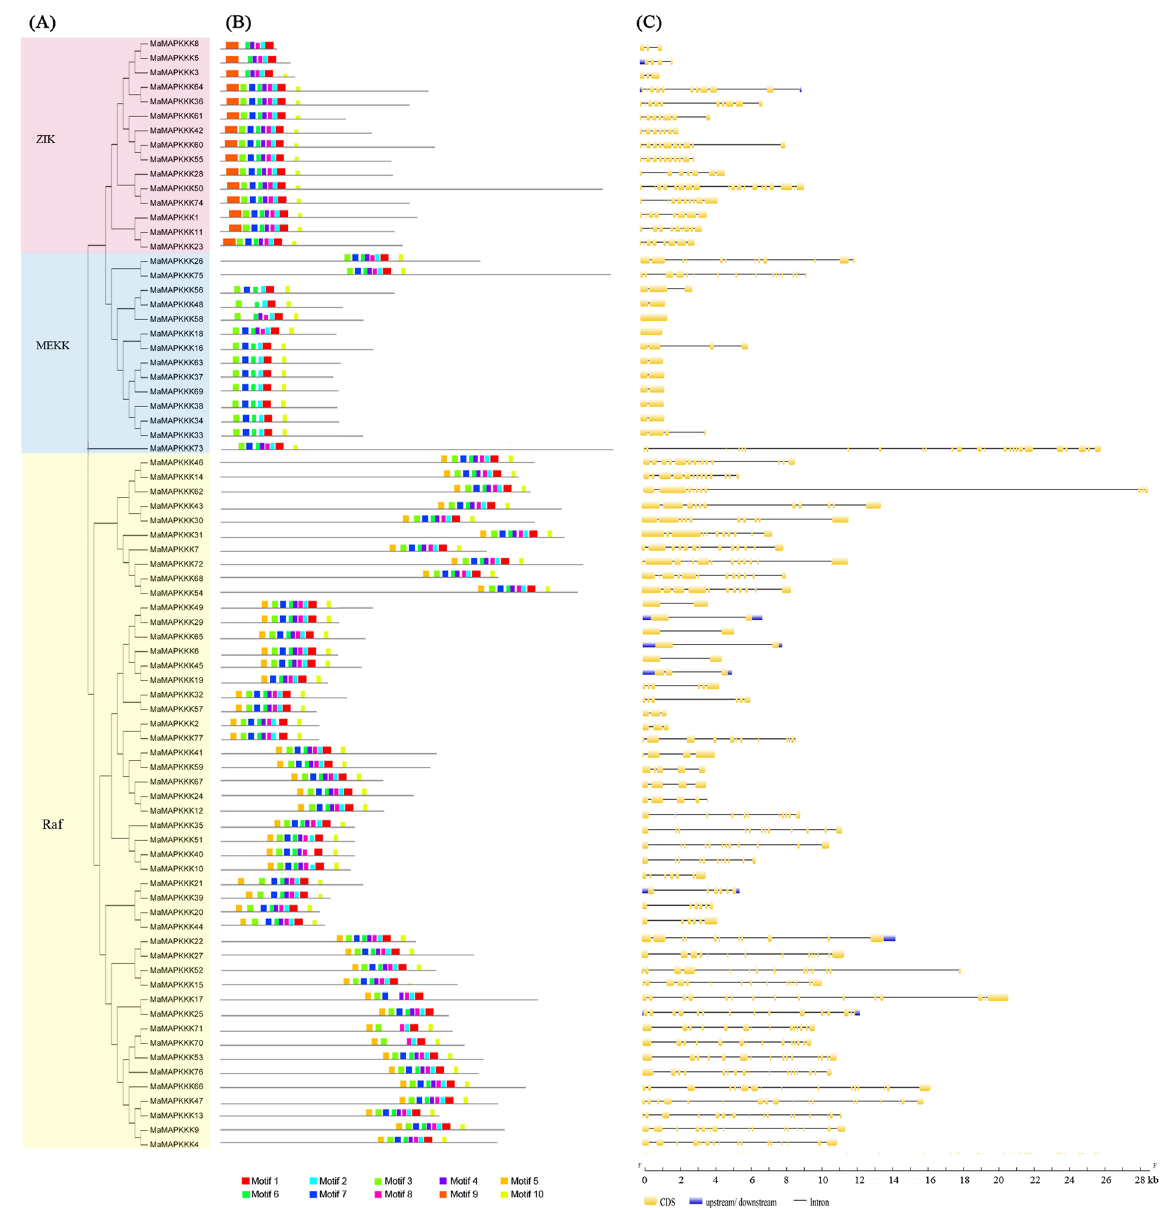
Figure 4. The phylogenetic relationship ( A ), conserved motifs ( B ) and gene structure analyses ( C ) of banana MAPKKK family. All motifs were identified by MEME database. The gene structures were drawn using GSDS database. The blue boxes, yellow boxes, and the black lines indicate upstream/downstream, exons and introns,